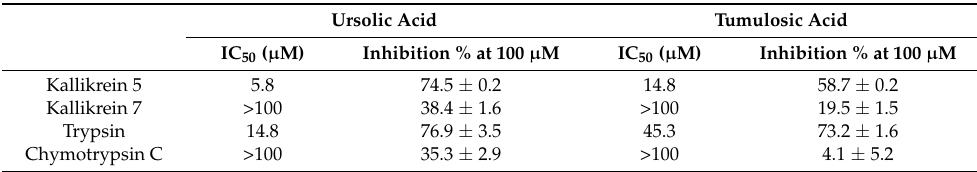
Table 2. Comparative activities of ursolic acid and tumulosic acid against serine proteases. Ursolic Acid